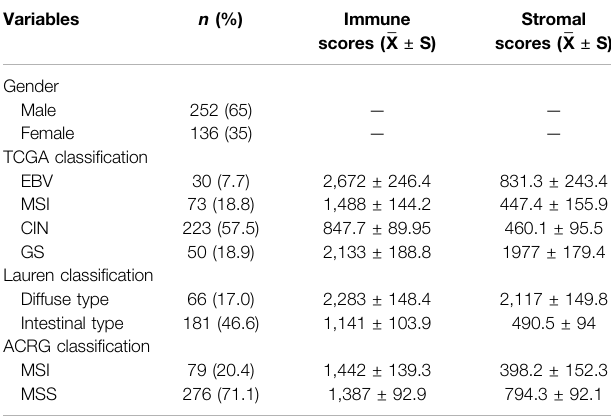
TABLE 1 | Clinical characteristics and immune/stromal scores of patients with gastric adenocarcinoma in the TCGA database.